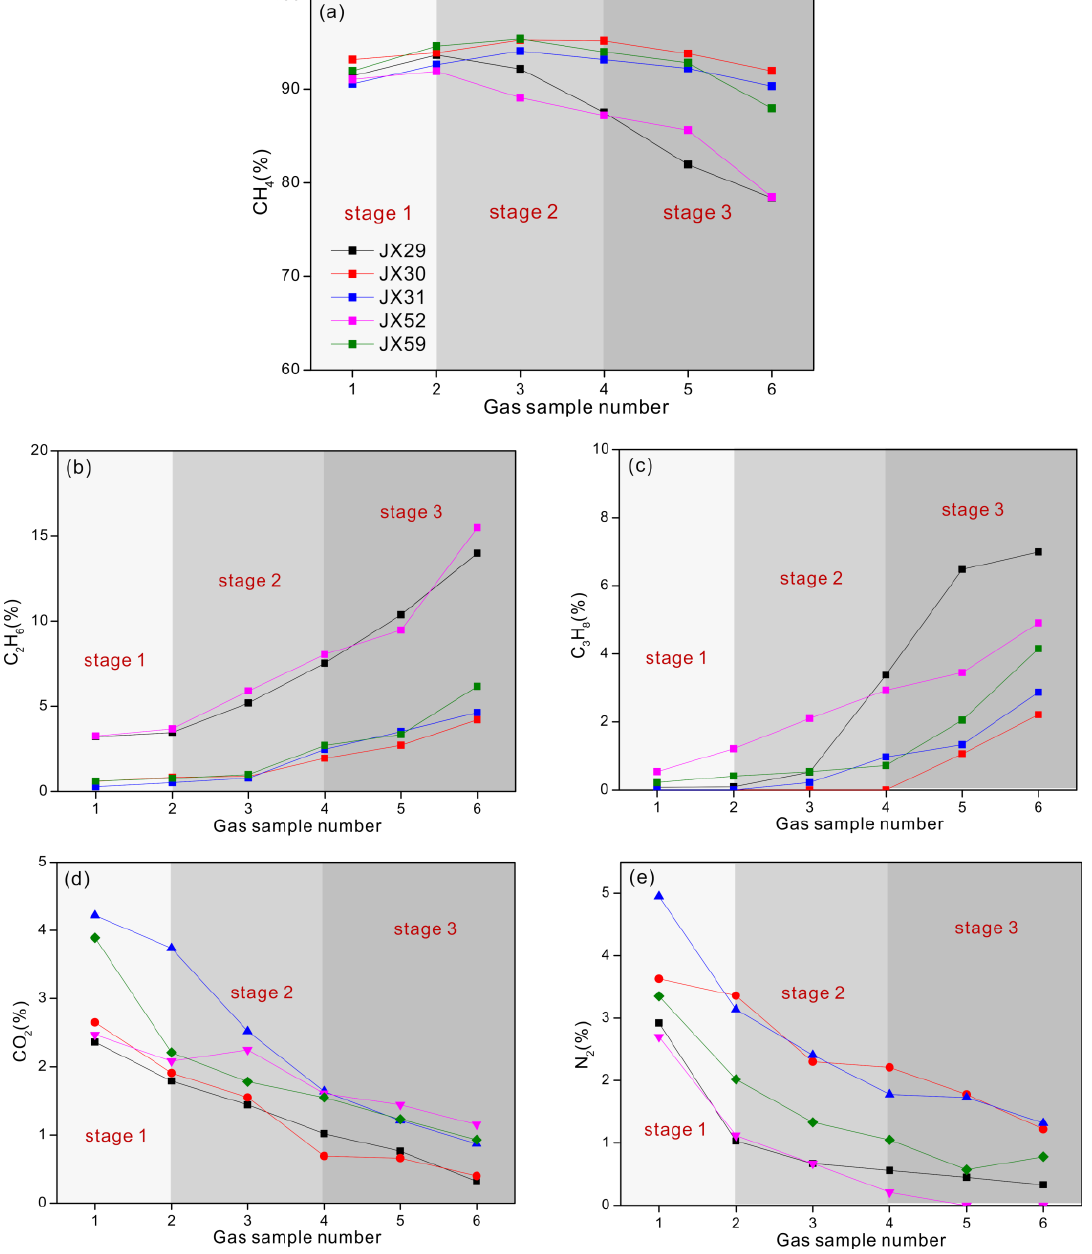
Figure 4. Gas composition variation during shale gas degassing from shale core samples (gas samples 1 and 2 were collected from stage 1; gas samples 3 and 4 were collected from stage 2; gas samples 5 and 6 were collected from stage 3). All gas components were corrected to remove the effect of air. ( a ) Variation in methane content during shale gas degassing from shale core samples. ( b ) Variation in ethane content during shale gas degassing from shale core samples. ( c ) Variation in propane content during shale gas degassing from shale core samples. ( d ) Variation in carbon dioxide content during shale gas degassing from shale core samples. ( e ) Variation in nitrogen content during shale gas degassing from shale core samples.